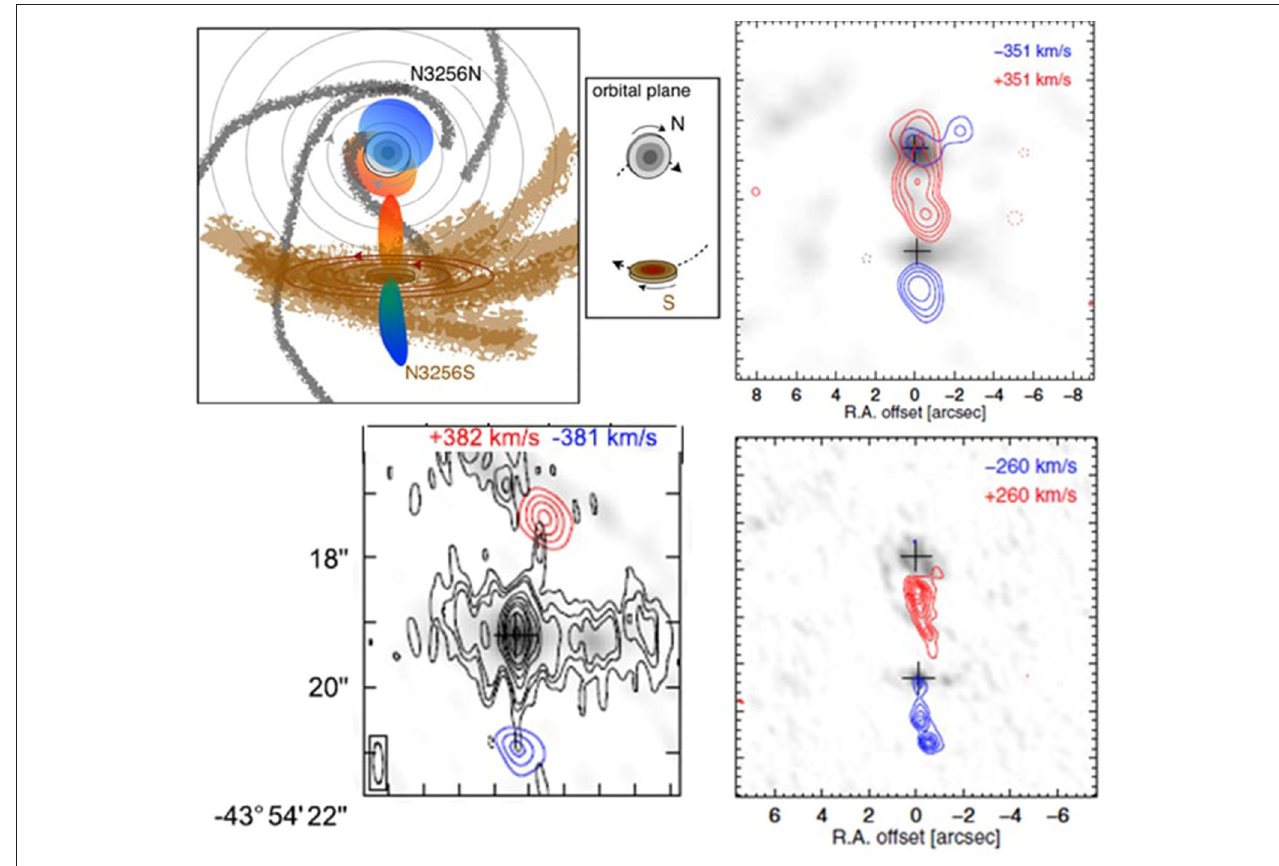
FIGURE 1 | ALMA observations of two molecular outflows in the merging galaxies NGC3256 (sketched at top left), adapted from Sakamoto et al. (2014), figure reproduced with permission. The northern object, almost face-on, reveals an outflow toward the observer, while the southern galaxy, nearly edge-on, shows a collimated outflow in the plane of the sky. The latter appears to coincide with a small radio jet, according to the VLA 3.6 cm radio map at the bottom left. The two CO maps at the right (top at low resolution, and bottom at high resolution) show that the northern outflow is resolved out. It must be a wide-angle outflow,